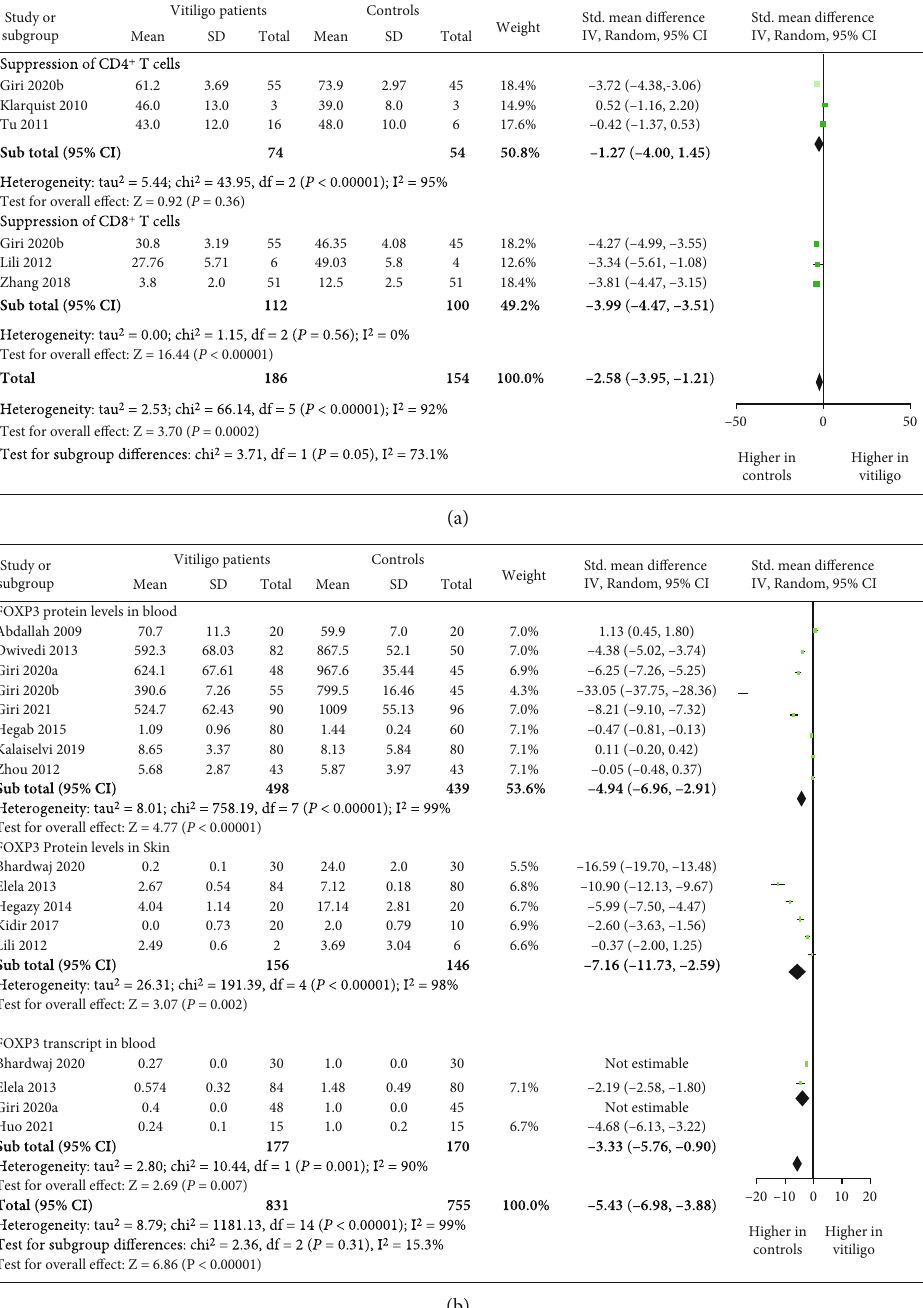
Figure 3: The forest plots for Tregs ’ suppressive capacity and FOXP3 expression in vitiligo patients and controls. (a) Tregs ’ suppressive capacity in vitiligo patients vs. controls ( p = 0 : 0002 ; SMD: -2.58[-3.95, -1.21]). Treg-mediated suppression of CD4 + T cells in vitiligo patients vs. controls ( p = 0 : 36 ; SMD: -1.27[-4.00, 1.45]). Treg-mediated suppression of CD8 + T cells in vitiligo patients vs. controls ( p < 0 : 00001 ; SMD: -3.99[-4.47, -3.51]). (b) FOXP3 expression in skin and blood of vitiligo patients vs. controls ( p < 0 : 00001 ; SMD: -5.43[-6.98, -3.88]). FOXP3 protein levels in blood of vitiligo patients vs. controls ( p < 0 : 00001 ; SMD: -4.94 [-6.96, -2.91]). FOXP3 protein levels in skin of vitiligo patients vs. controls ( p = 0 : 002 , SMD: -7.16 [-11.73, -2.59]). FOXP3 transcripts in blood of vitiligo patients vs. controls ( p = 0 : 007 , SMD: -3.33 [-5.76,